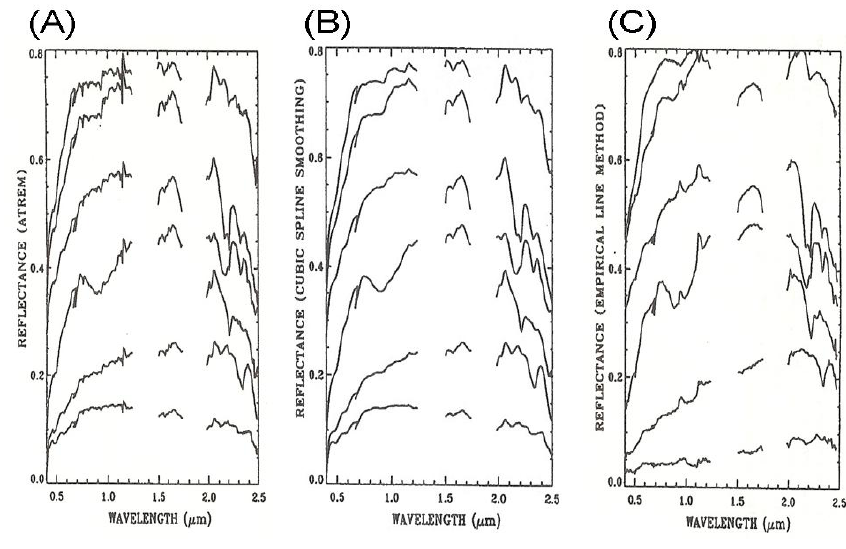
Figure 5. ( A ): Six reflectance spectra (displaced vertically for clarity) derived with ATREM from AVIRIS data acquired over Cuprite, Nevada in June, 1995; ( B ): six smoothed reflectance spectra corresponding to those in (A); and ( C ): six reflectance spectra derived with the empirical line method and corresponding to those in